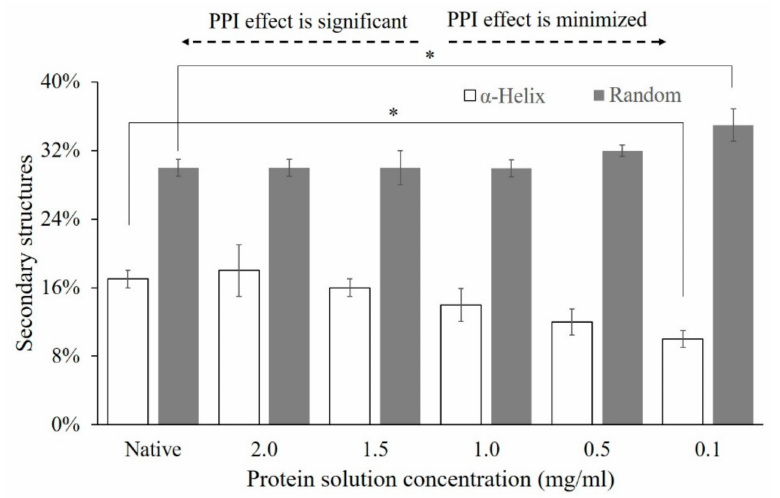
Figure 2. Secondary structure content (%) of α -amylase adsorbed onto the hydrophilic glass surface from different bulk solution concentrations. “Native” presents the native protein structure in the solution. The error bars denote the mean ± SD for n = 3. * represents the significant difference with p < 0.05.